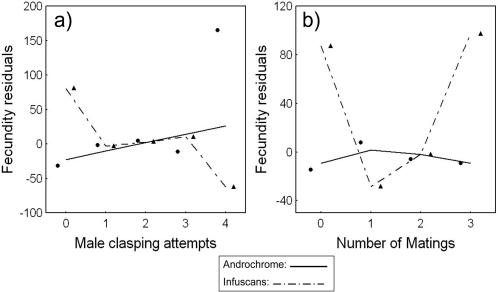
Fitness functions (cubic splines) showing morph-specific relationships between fecundity and minimum recorded number of mating attempts and realized matings.The fecundity-effects of population and year were removed prior to this analysis (fecundity-residuals are shown on Y-axis). Androchrome females (n = 200, solid lines and circles) and Infuscans-females (n = 78, broken lines and triangles), differ both with respect to a) Male clasping attempts (Morph * No. claspings: χ2 = 7.657, d.f. = 1, P = 0.006) and with respect to b) Number of matings (Morph * No. matings: χ2 = 4.755, d.f. = 1, P = 0.029). Interaction tests were estimated in generalized linear models (GLZ; with Poisson error, see methods). Because there were only 5 individuals across all morphs that had mated four times, these were excluded from the final model, however, results remained significant with their inclusion. Data-points show mean fecundity values for each particular morph and mating category.